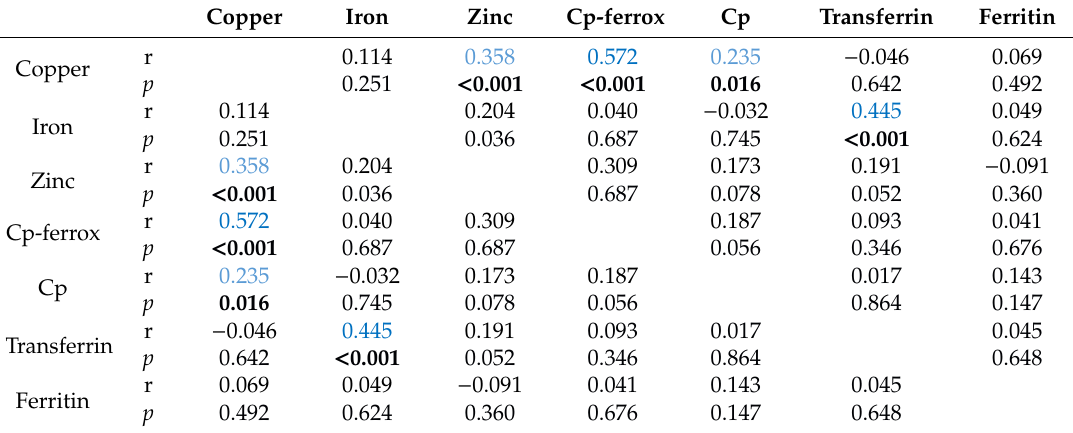
Table 6. Partial correlation between changes from week 0 to week 2 in metal and metal metabolism markers adjusted for BMI and sex. p < 0.05 are shown in bold with positive associations (r > 0) shown in blue. Zinc